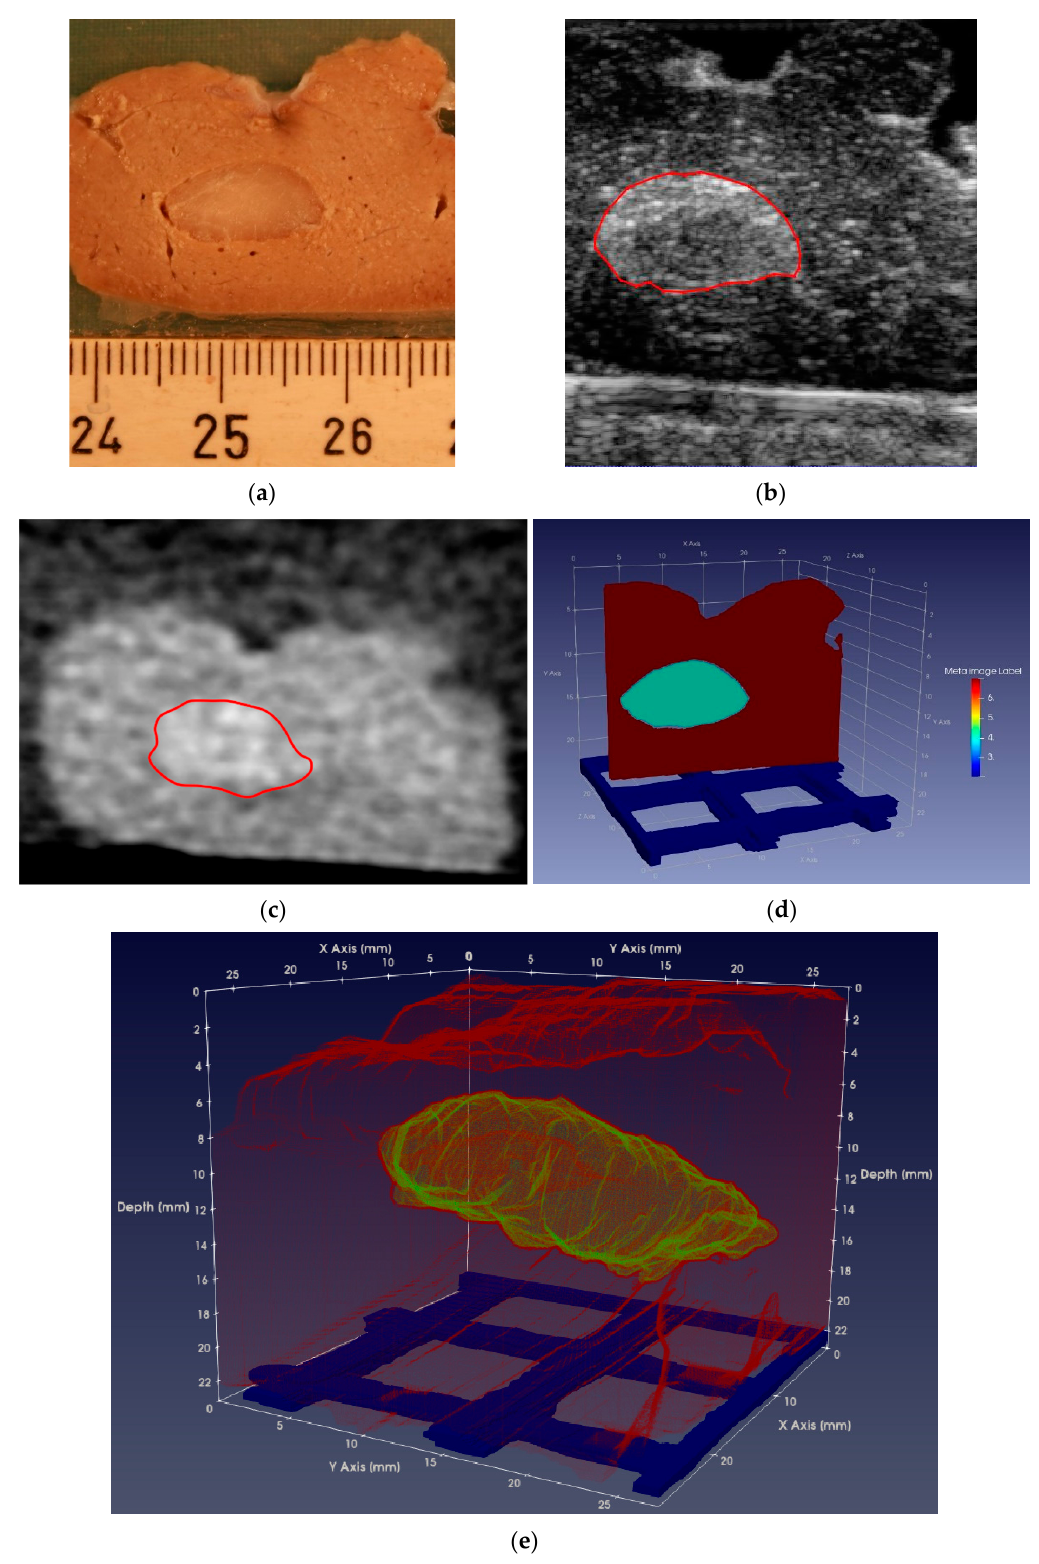
Figure 3. An example of the correlation between slices for gross pathology assessment and corre- sponding imaging. ( a ) Specimen slice, ( b ) corresponding slice on 3D ultrasound image, ( c ) corre- sponding slice on CT image, ( d ) corresponding slice on segmentation, and ( e ) 3D segmentation of the animal model.